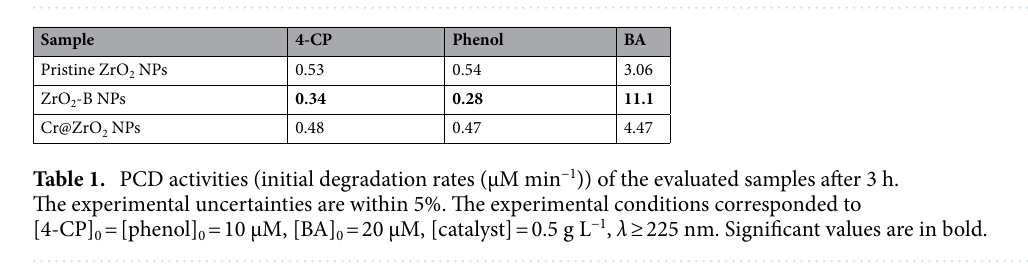
Figure 2. PCD activity of ( a ) 4-CP, ( b ) phenol, and ( c ) BA over ZrO 2 , ZrO 2 -B, or Cr@ZrO 2 NPs under UV light irradiation ( λ ≥ 225 nm). The PCD activities extracted from the plots are listed in Table 1.